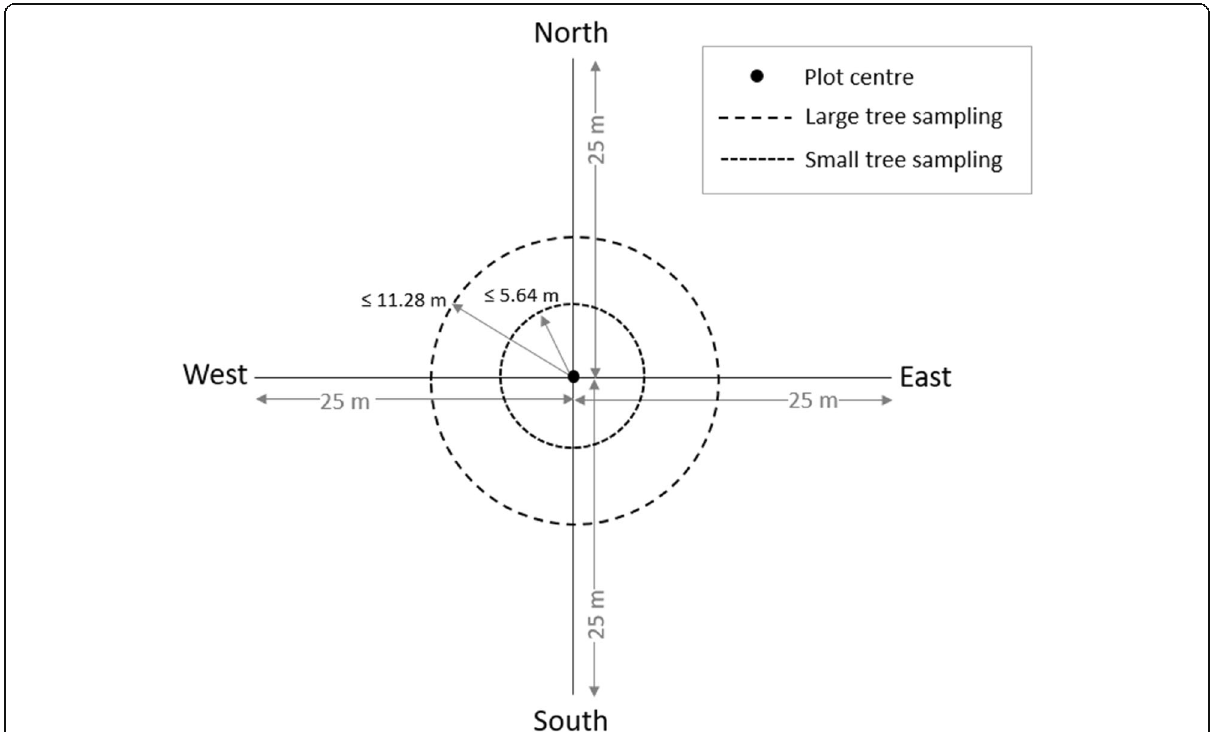
Fig. 2 Plot layout showing plot center, 25 m transects in each cardinal direction and maximum sampling radius for large and small